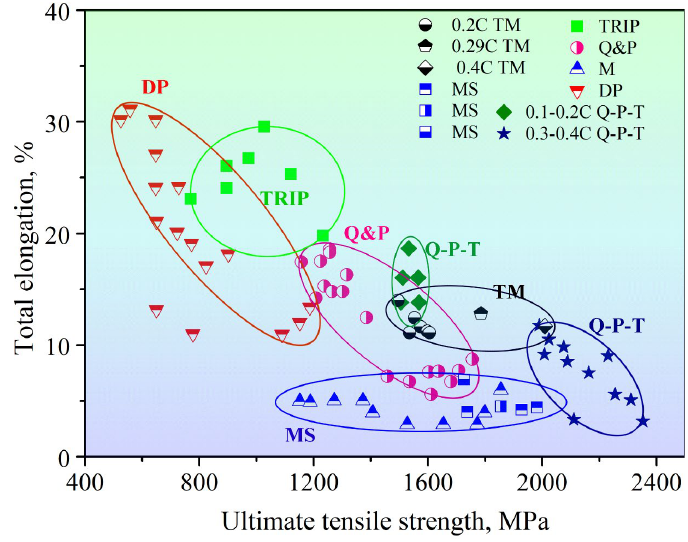
Figure 4. Comparison of tensile strength and elongation of TM steels [35–38], DP steels [39], TRIP steels [39], martensitic steels [26,33,34,39], Q&P steels [39], and Q-P-T steels [40]. This figure is reproduced based on [28,35–42].